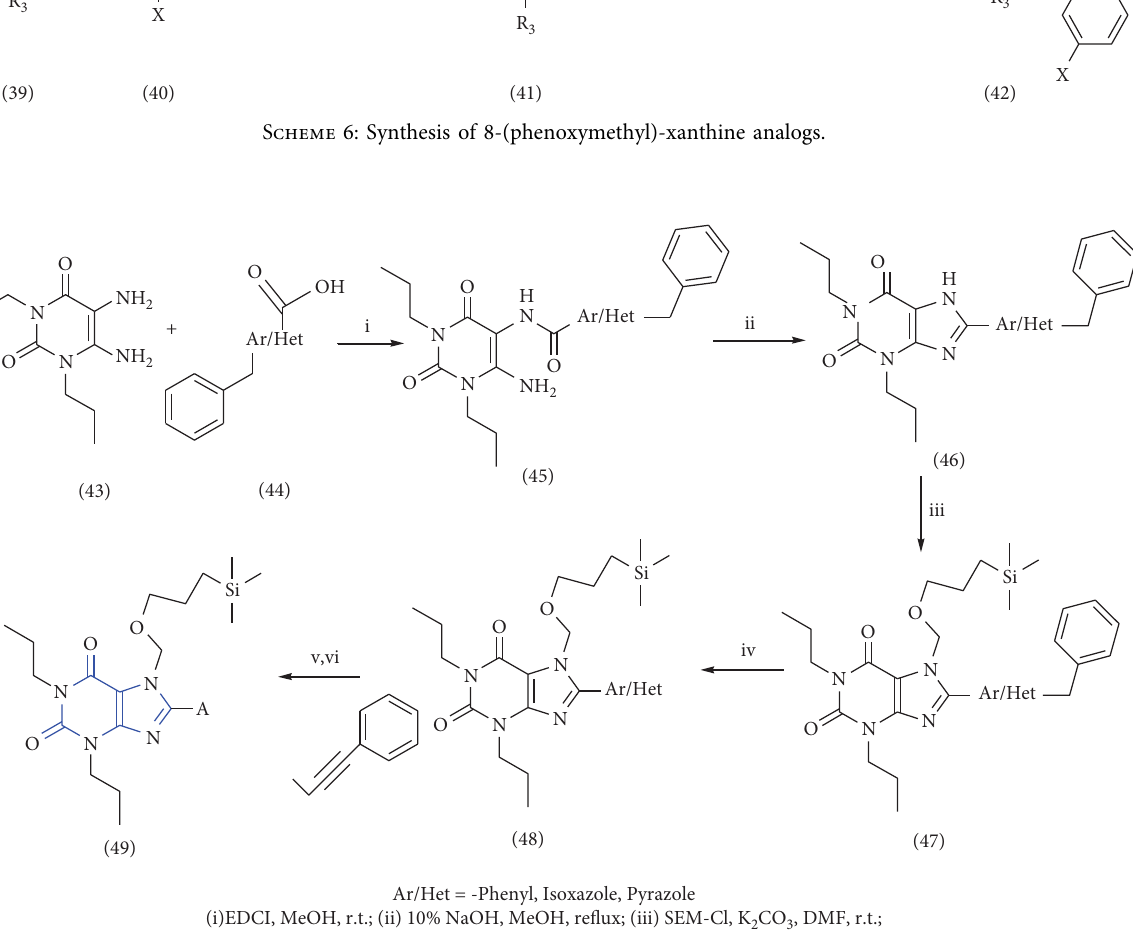
Scheme 7: Synthetic scheme of 1-,3-,8-substituted